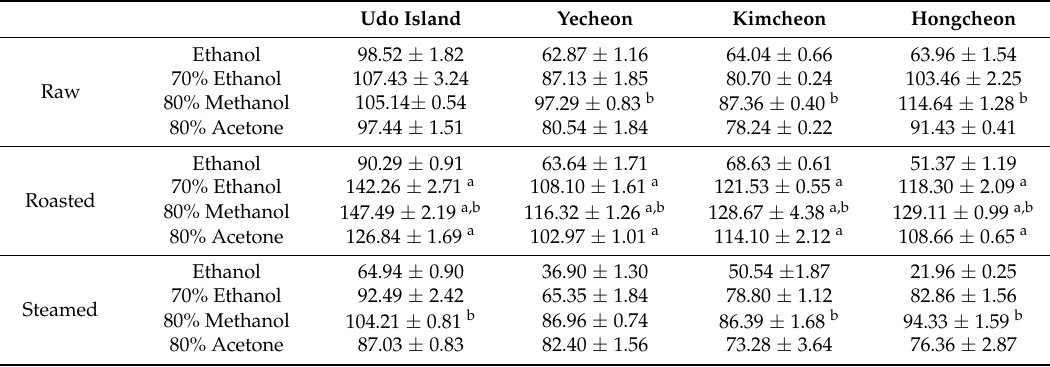
Table 4. Effect of processing and extraction solvent on the total amounts of phenolic contents in peanut extracts. Udo